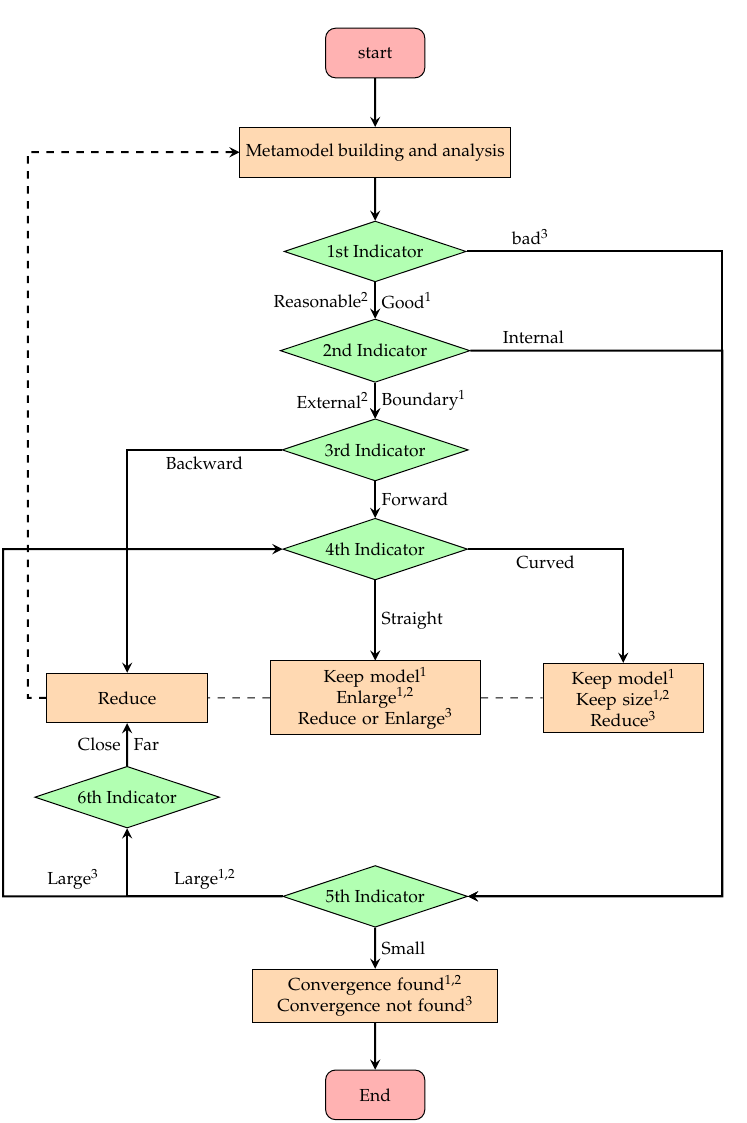
Figure 3. Overview of trust region strategy in